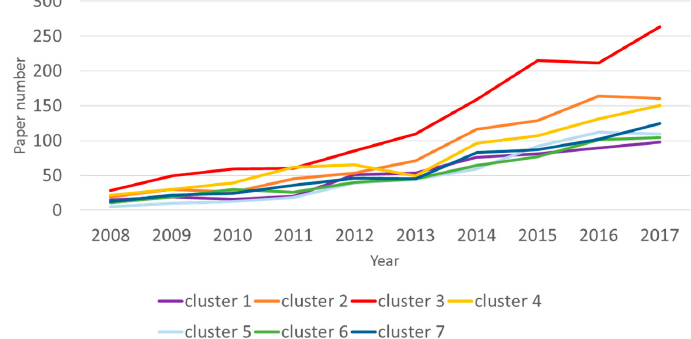
Figure 11. Literature paper trend of all clusters. The topic contents for each cluster and the corresponding key words or phrases are listed in Table 3. Cluster 1 relates to CSP thermal collecting and storage systems with keywords of CSP plant, steam, efficiency, parabolic trough, thermal storage, heat and receiver. Clusters 2 and 5 are related to the simulation of grid-connected energy storage and supply systems, with Cluster 2 targeting on-grid